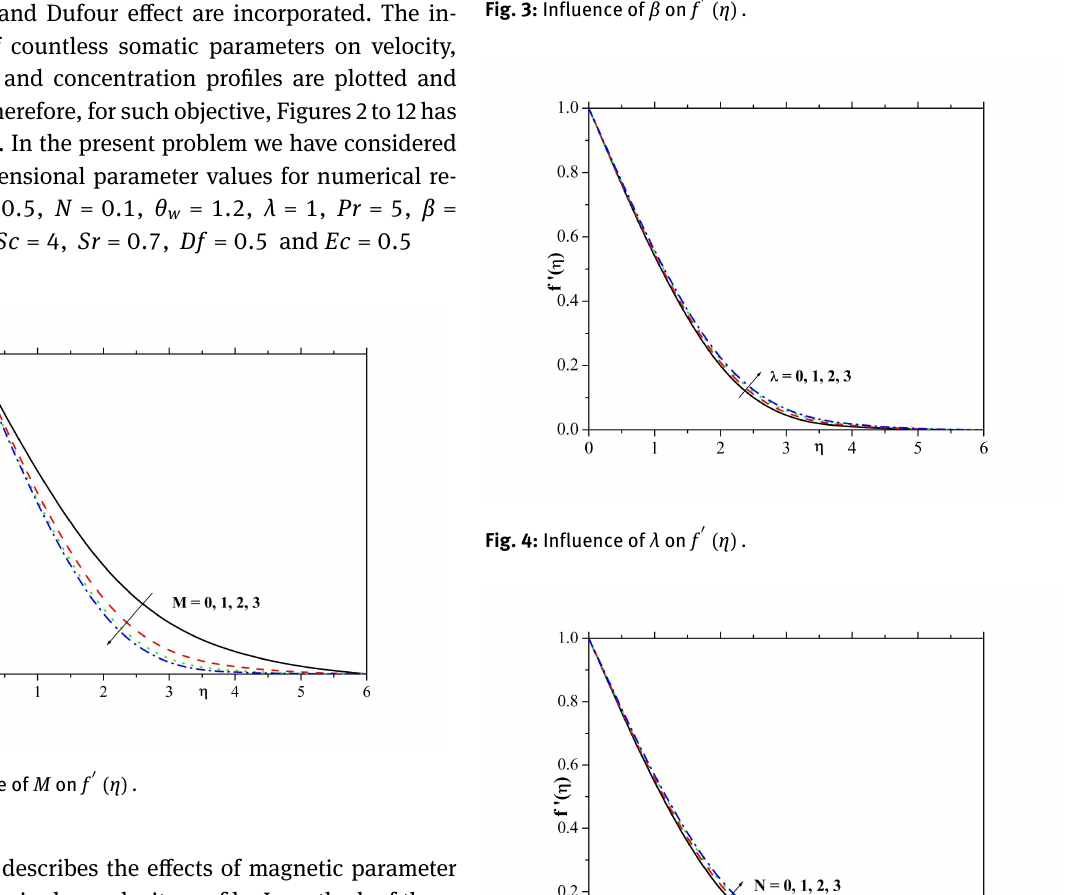
Fig. 3: Influence of β on f ′ ( η ) .